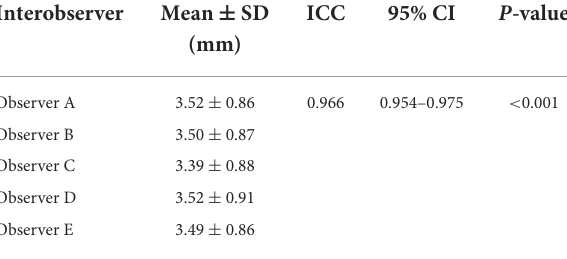
TABLE 4 Interobserver reliability for the total urethral thickness measurements of 115 dogs using ICC and their 95% CI.